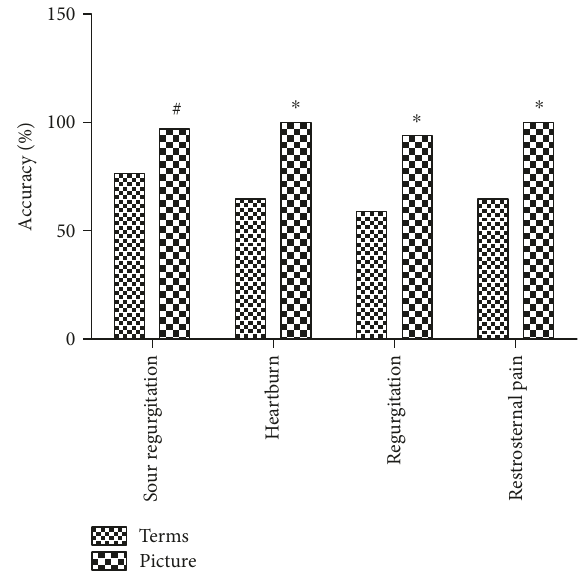
Figure 4: In fl uence of pictograms on understanding classic re fl ux symptoms in people without medical background in community.